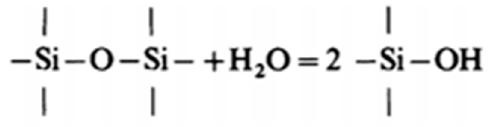
Figure 21. Dissolution of silica during wet oxidation. Reprinted with permission from Reference [68]. Copyright 1981 Acta Chemica Scandinavica,